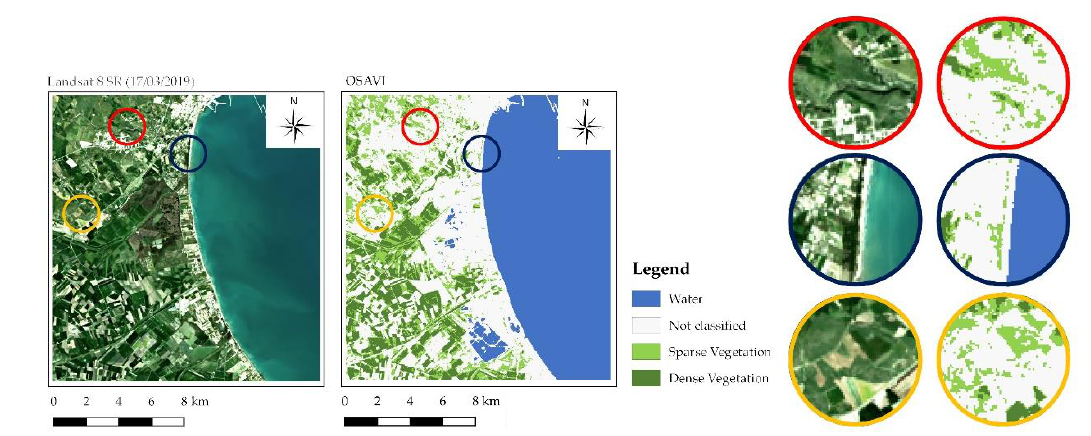
Figure 4. Optimized Soil Adjusted Vegetation Index (OSAVI) classification outcome for Landsat 8 (image acquired on 17 March 2019). On the right, zoomed images with some misclassifications.